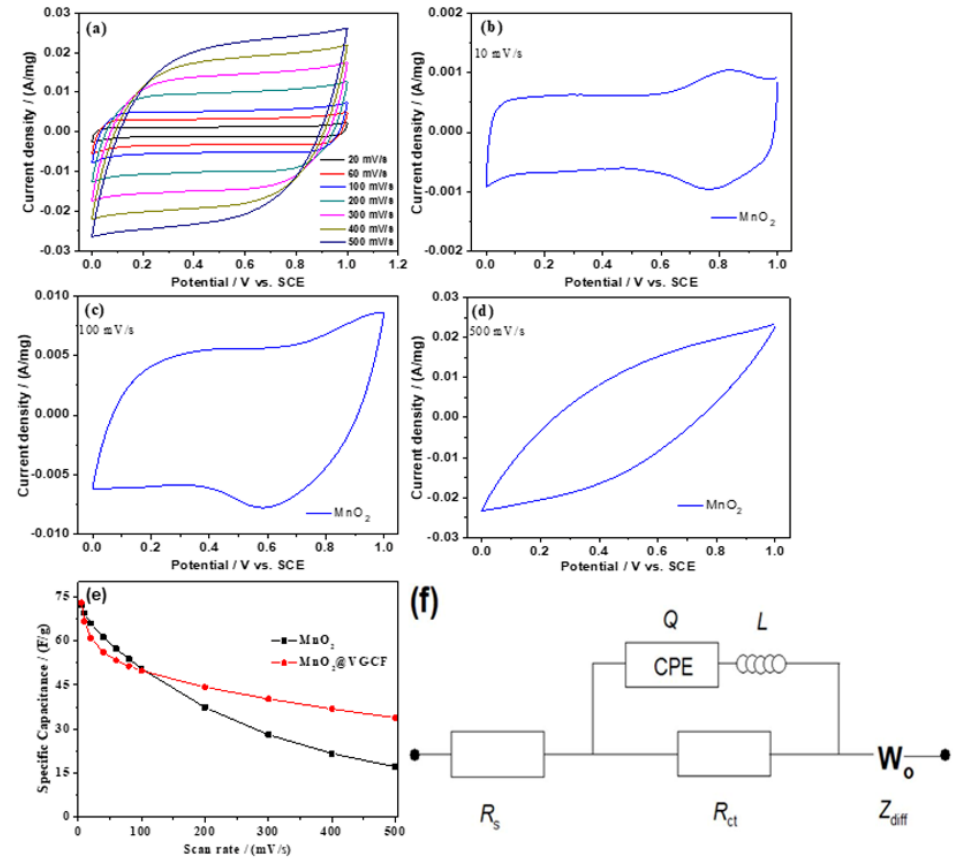
Figure 4. ( a ) CV curves of MnO 2 @VGCFs; ( b – d ) CV curves of MnO 2 at 10, 100, 500 mV s − 1 in 0.5 M K 2 SO 4 aqueous electrolyte, respectively; ( e ) changes in capacitance of MnO 2 and MnO 2 @VGCF at different scan rates; ( f ) equivalent circuit used for fitting impedance spectra of the MnO 2 and the MnO 2 @VGCF.